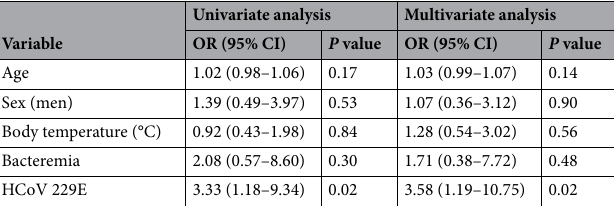
Univariate analysis Multivariate analysis Variable